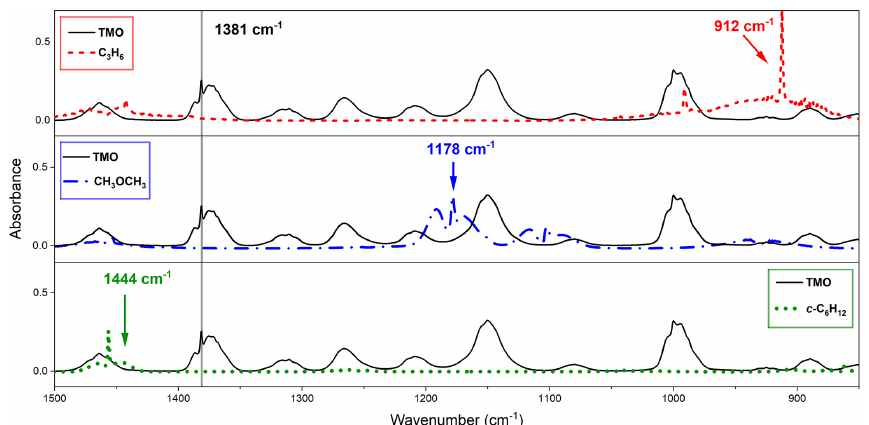
Figure 3. Observed FTIR spectra from this work with typical monitoring frequencies indicated: TMO (black solid line), monitored at 1381cm − 1 where reference compounds did not appreciably absorb, for C 3 H 6 (the dashed red line) at 1381cm − 1 , and CH 3 OCH 3 (dotted– dashed blue line) and c -C 6 H 12 (dotted green line) at 1444cm − 1